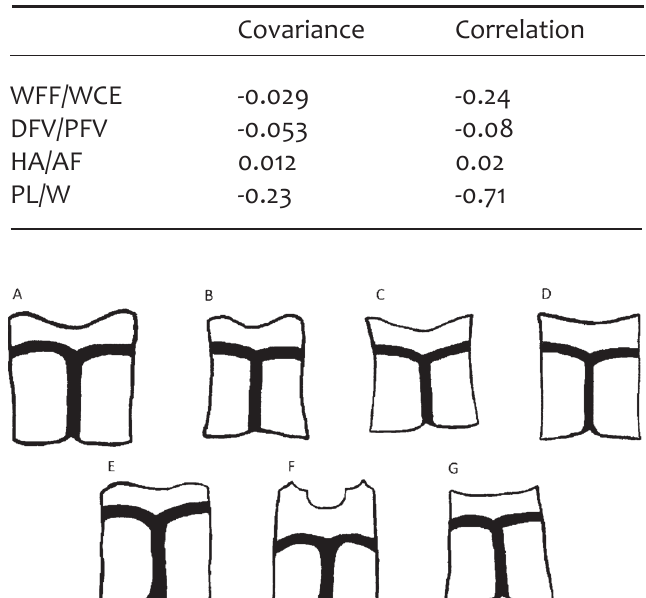
Table 2. Covariance and correlation of morphometric char- acters with carapace length. Abbreviations: WFF, carapace width at margin where the fourth and fifth marginal scutes meet; WCE, carapace width at midpoint of eight marginal scute; D FV, distal width of first vertebral scute; PFV, proximal width of first vertebral scute; HA, distance between humeral/ abdominal sulcus and the hyo/hypoplastral suture at the mid- line; AF, distance between the abdominal/femoral sulcus and the hyo/hypoplastral suture at the midline; PL, pygal length at the midpoint; PW, pygal width at the midpoint.